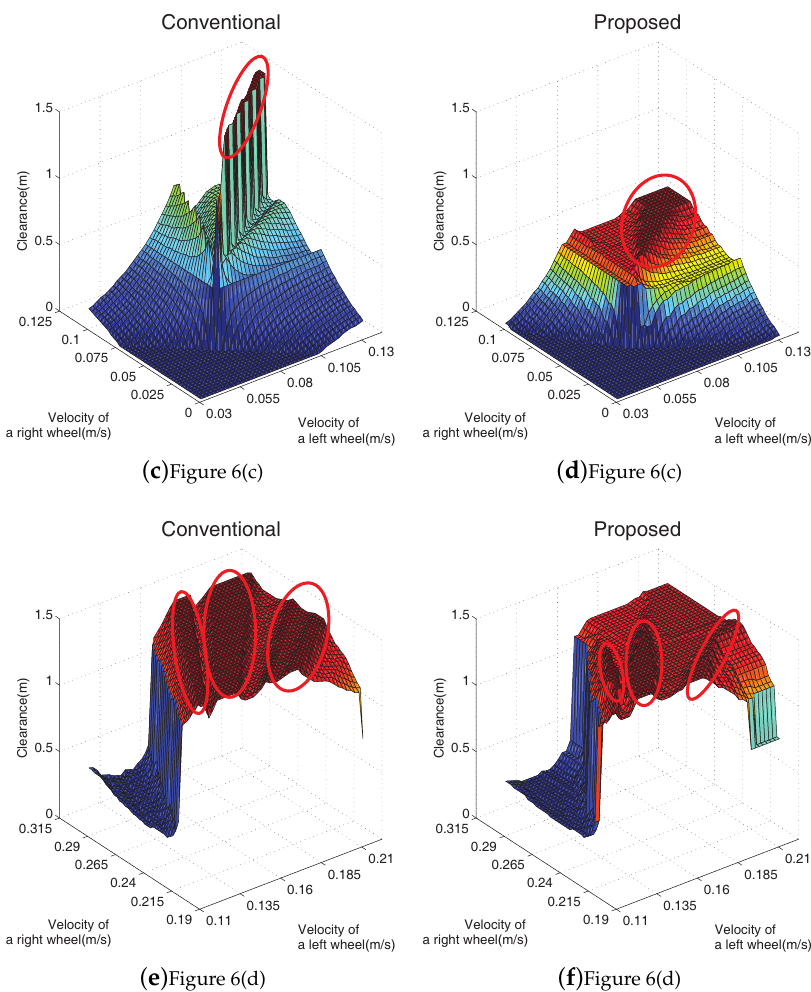
Figure 7. The clearance of the simulation environments.